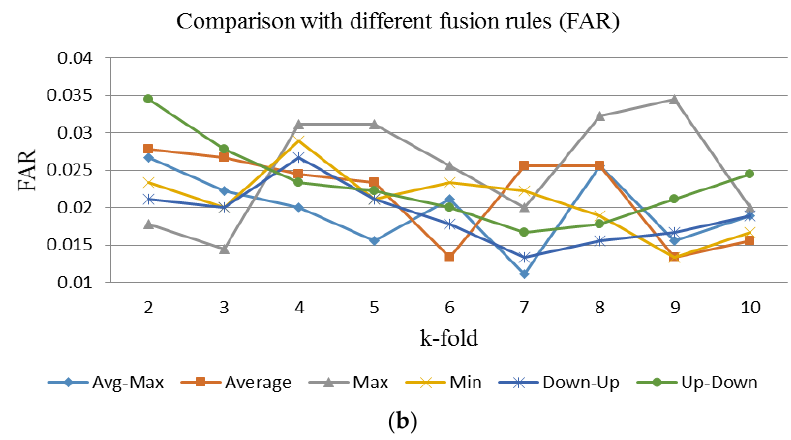
Figure 18. The FRR and FAR of fused images fused by using the proposed hybrid fusion rule, Avg-Max, and the other fusion rules with 32 × 32 block size and various k-holds. ( a ) FRR of fused image verification with different fusion rules; ( b ) FAR of fused image verification with different fusion rules.